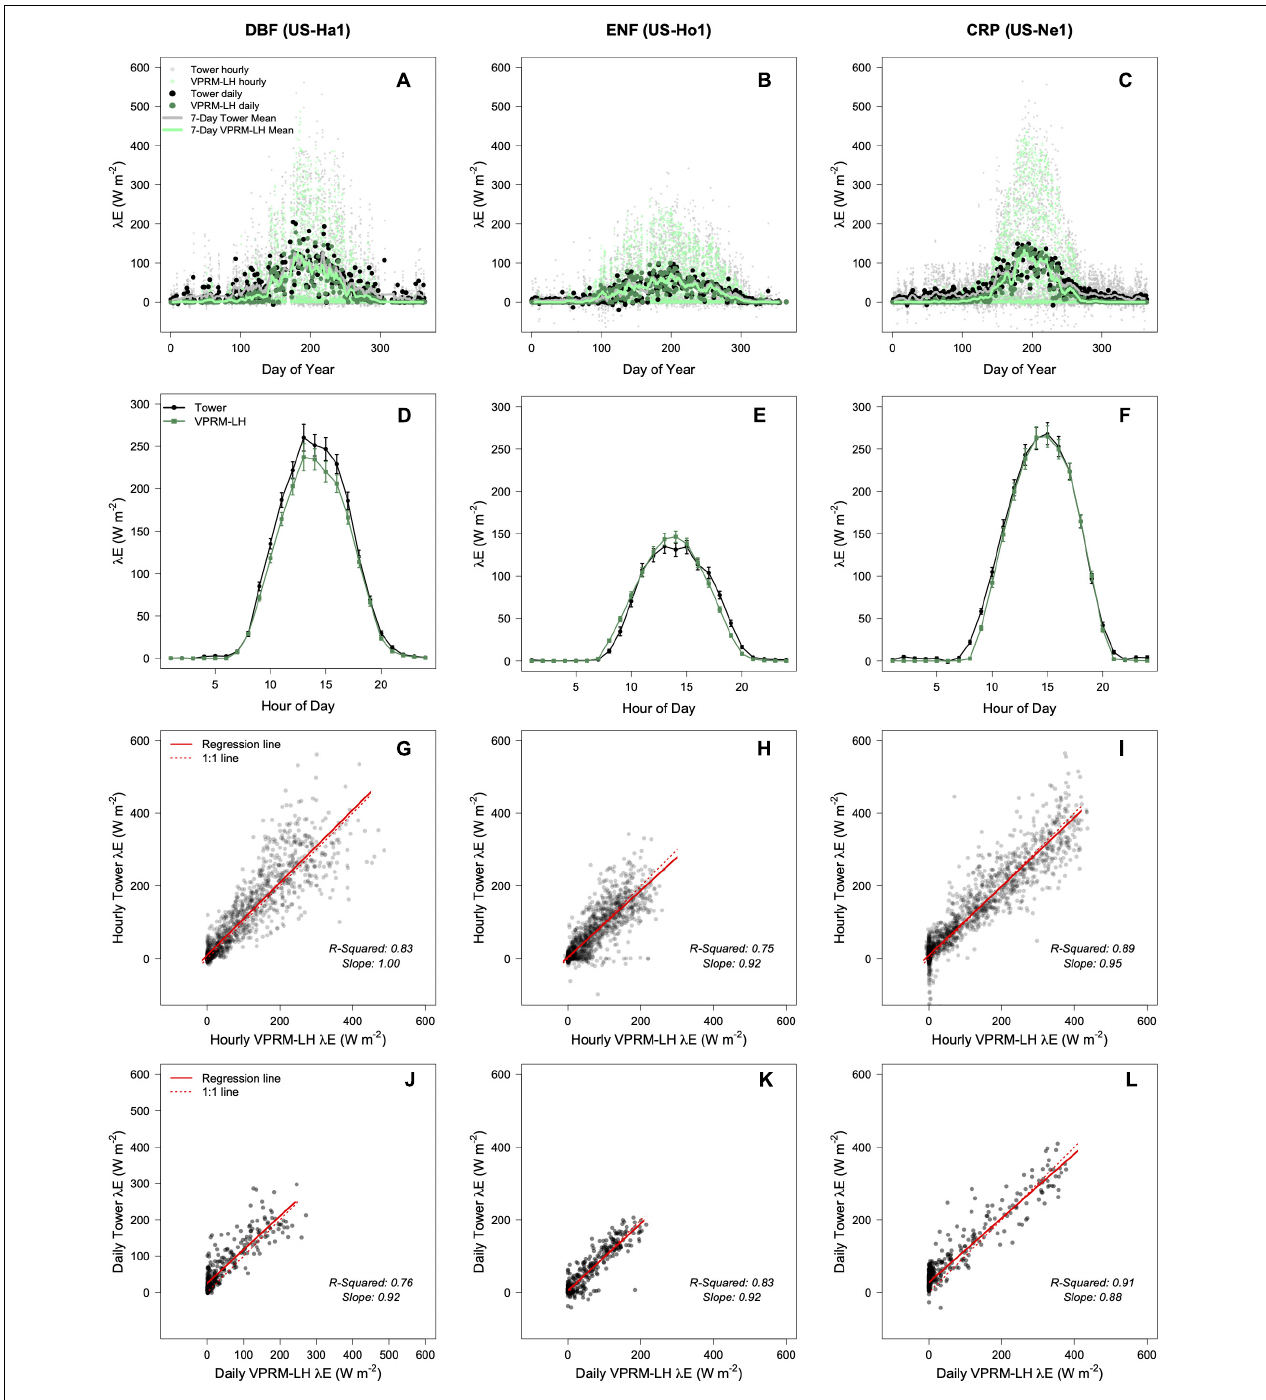
FIGURE 1 | Comparison of modeled vs. measured λ E at DBF, ENF, and CRP flux tower sites. (A–C) Annual trends in hourly, daily, and weekly λ E. (D–F) Average diurnal λ E patterns during JJA. Error bars represent standard error for each hour during JJA. (G–I) Scatter plots of modeled vs. measure λ E for each hour during JJA. (J–L) Scatter plots of modeled vs. measured daytime average λ E over the entire year.